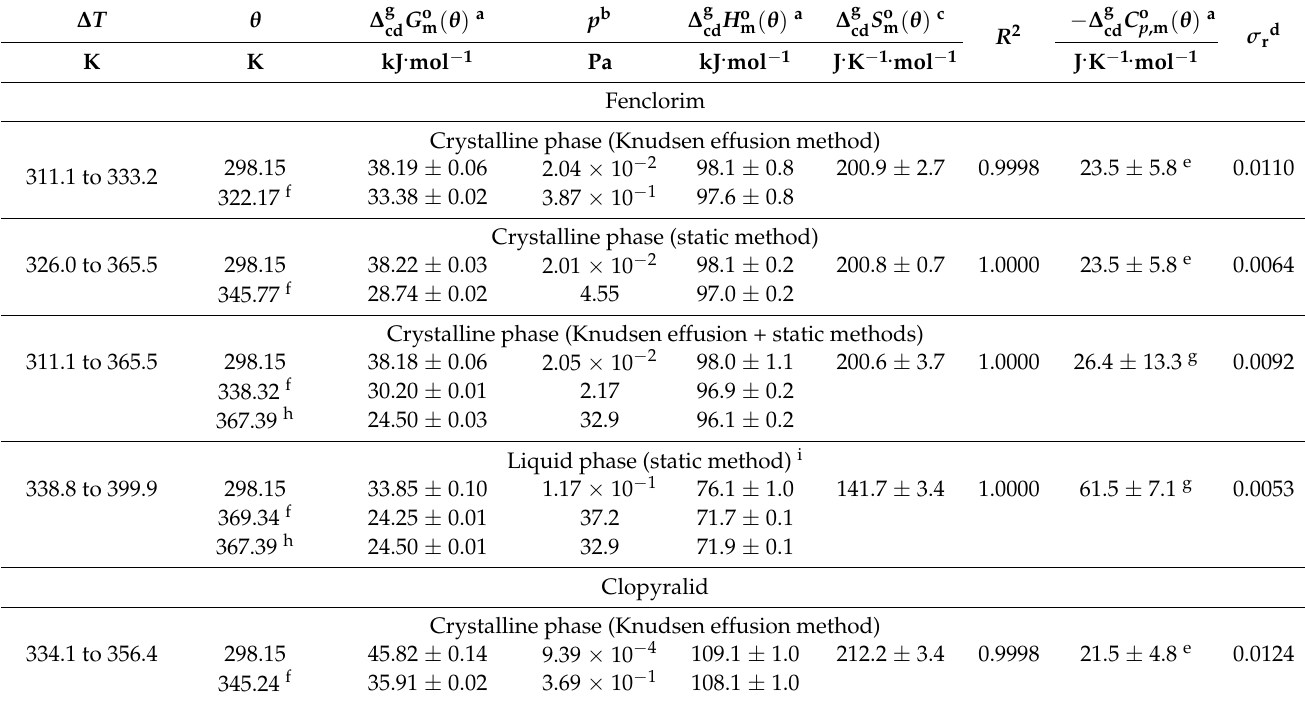
Table 3. Standard ( p o = 10 5 Pa) thermodynamic properties of sublimation and of vaporization of the compounds